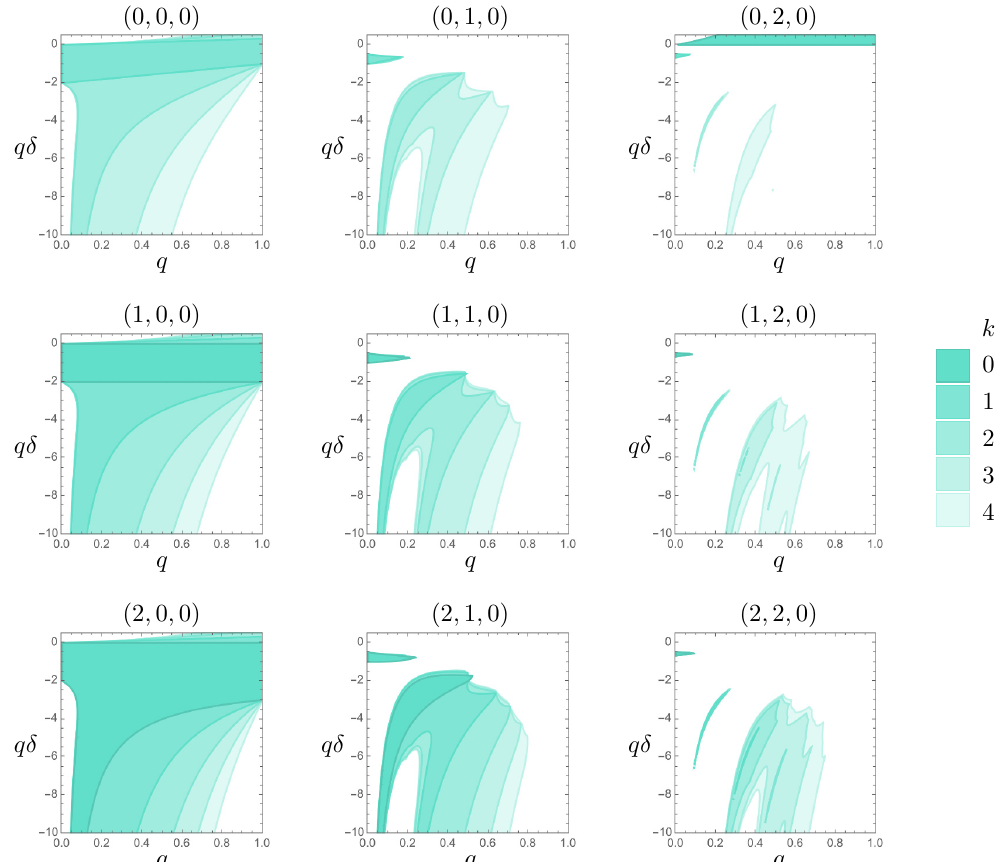
Figure 2 . Numerical plots depicting the parameter space for which all partial waves on the k th residue are unitary. Positive regions are represented in the ( q, qδ ) plane for various choices of ( α, β, γ ) in D = 4 . Note that for the ( α, β, γ ) = (0 , 0 , 0) and (0 , 1 , 0) theories, the k = 0 pole is not depicted: for (0 , 0 , 0) it is trivially positive, while for the (0 , 1 , 0) case there exists no choice of ( q, δ ) consistent with positivity for k = 0